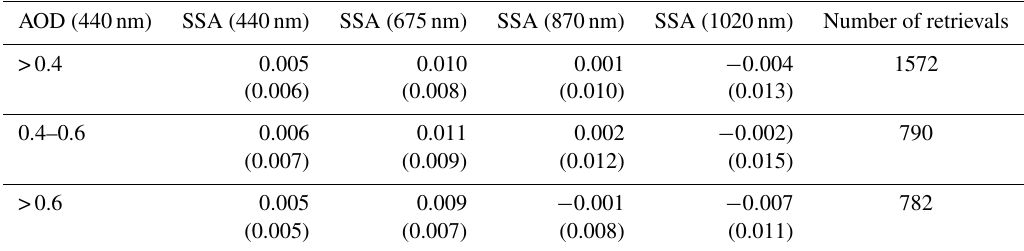
Table 7. Statistics, average values and standard deviations (in parentheses) of the difference in SSA retrievals of V2 and V3 for the Mongu site. The difference is defined as V3 − V2.